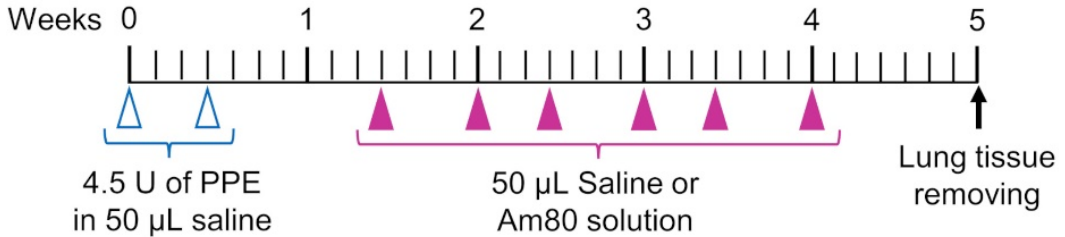
Figure 1. Experimental schedule.